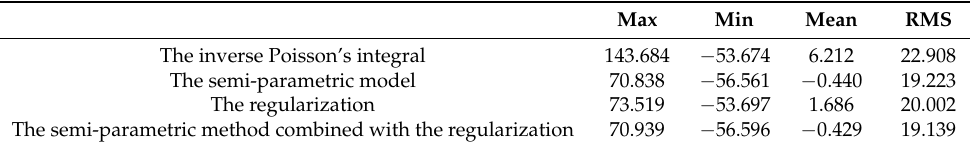
about 0.5 mgal which is much smaller than the current airborne gravimetry error level. The Sensors 2017 , 17 , 1205 10 of 15 smoothing parameter is 0.020 and regularization parameter is 2.529. Table 5. Statistics of the differences between the downward continued values and the original EGM08 values in the Tibetan Plateau (mgal).